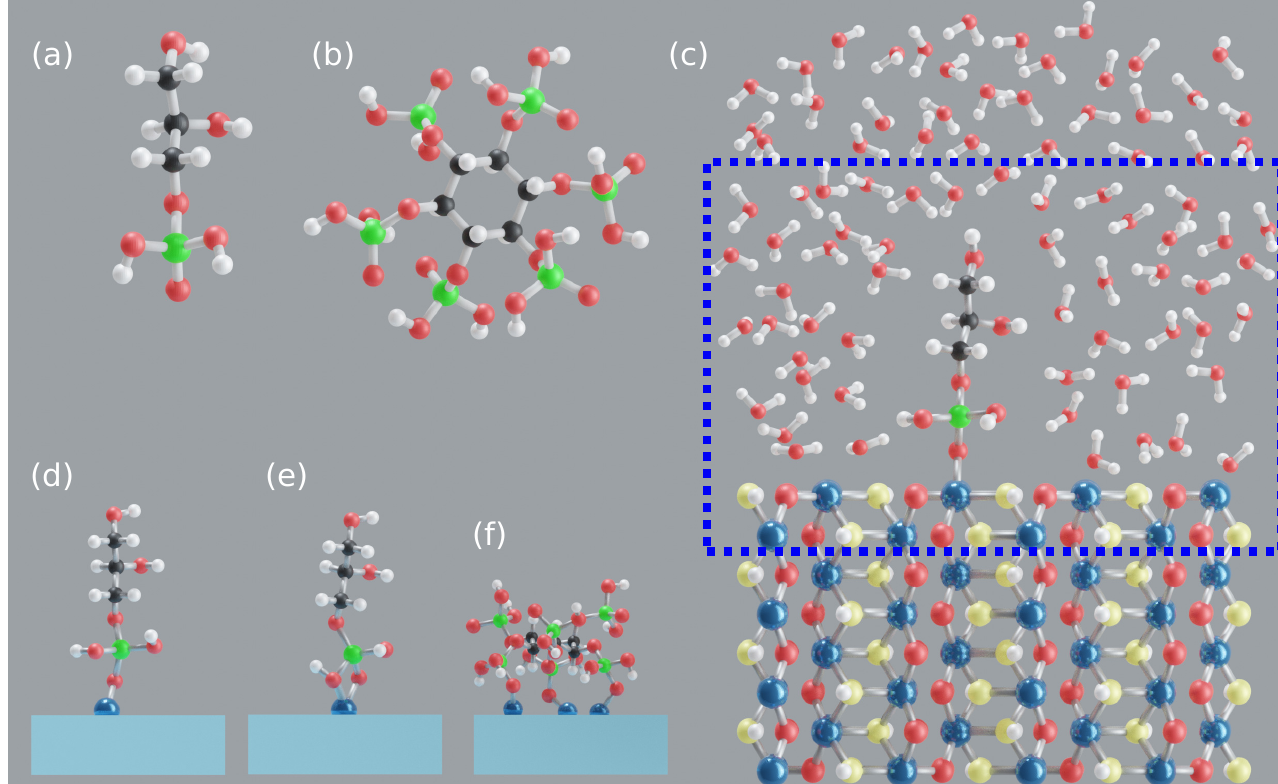
Figure 1. GP [C 3 H 9 O 6 P] ( a ), IHP [C 6 H 18 O 24 P 6 ] ( b ), goethite-GP-water complex ( c ), M motif ( d ), B motif ( e ), and 3M motif ( f ). Blue, red, yellow, white, black, and green colors correspond to iron, bridging oxygen, hydroxyl oxygen, hydrogen, carbon, and phosphorus atoms, respectively. The dotted line denotes the QM